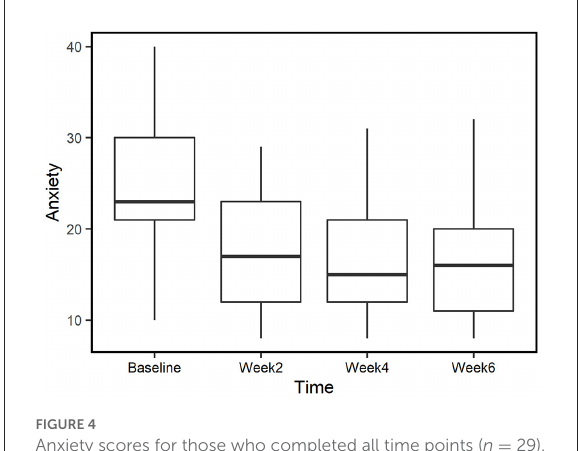
FIGURE4 Anxiety scores for those who completed all time points ( n = 29). Median values are represented by horizontal black lines in the box